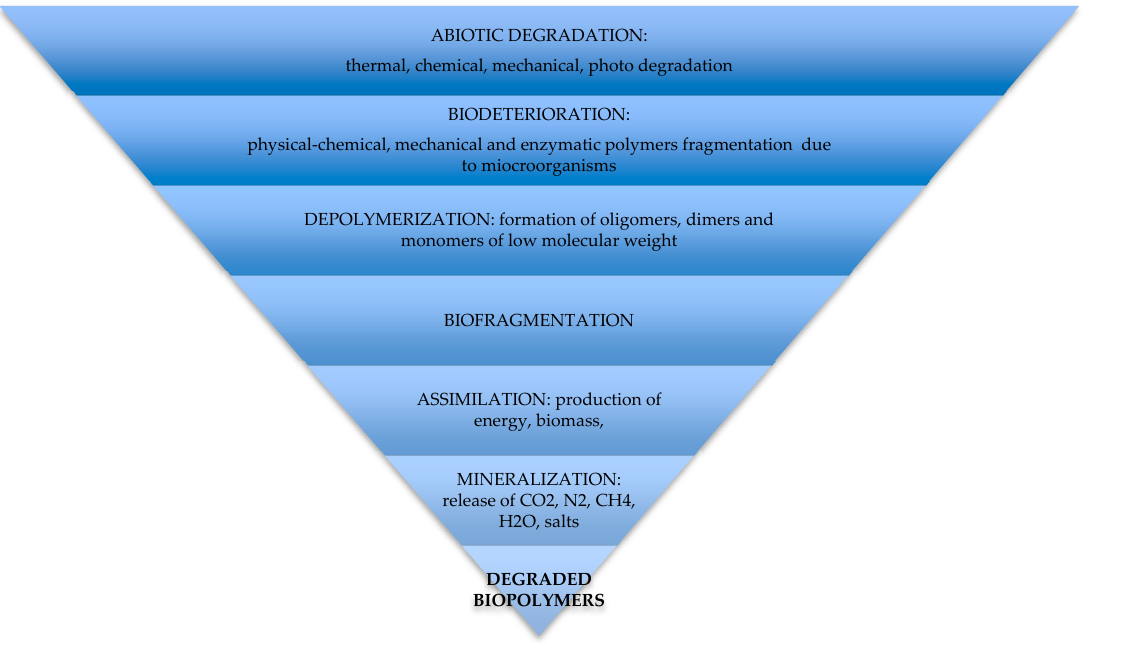
Figure 5. Biopolymers degradation steps.